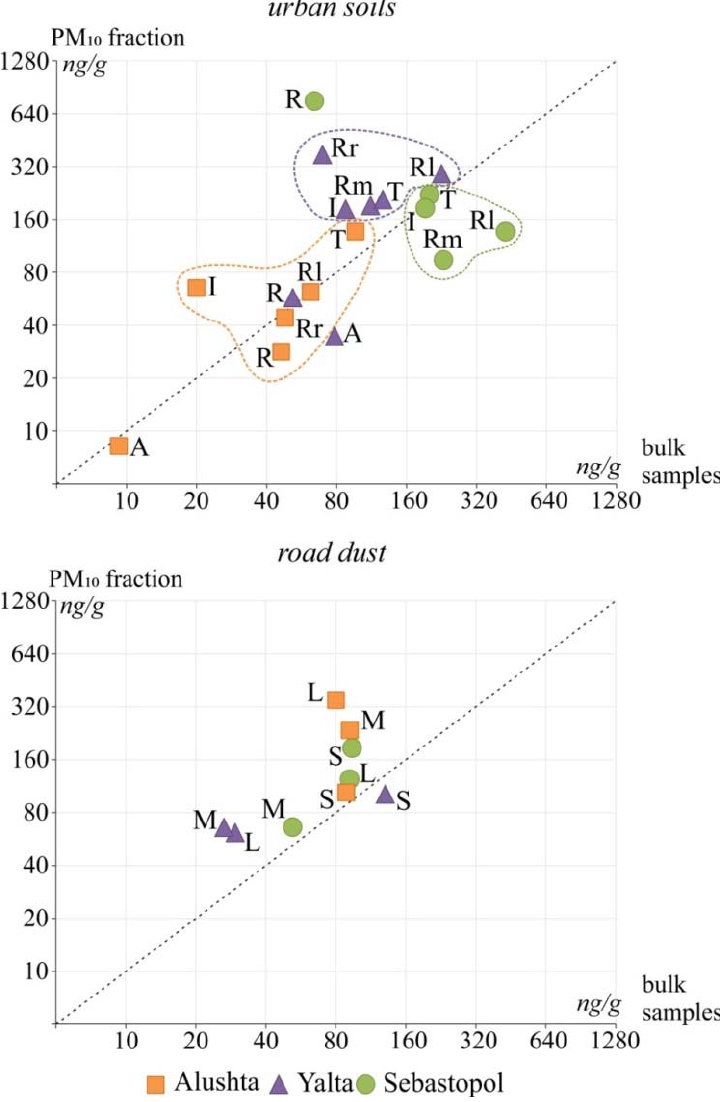
Figure 7. Fractionation of benzo(a)pyrene in soils and road dust in Alushta, Yalta and Sebastopol. Land use zones: T—traffic, I—industrial, Rm—residential multi ‐ storey, Rl—residential low ‐ rise, Rr—residential and recreational, A—agrogenic, R—recreational. Road type: L—large, M—medium, S—small.